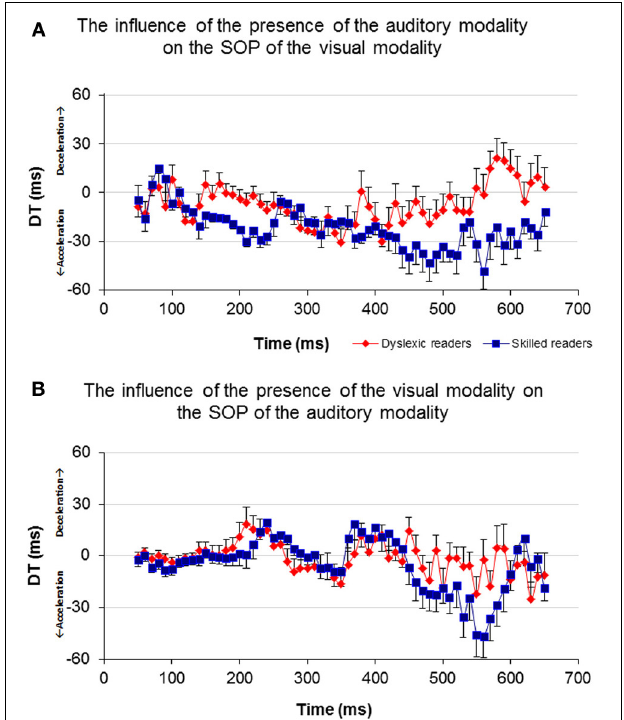
FIGURE 5 | The percentage of participants included in every comparison. Note the inverted ‘U’ shape of the visual process graph where at the beginning and end of the process the percentage of participants is relatively low compared to the middle. In contrast to the visual process’s graph, the auditory graph is stable at the beginning.